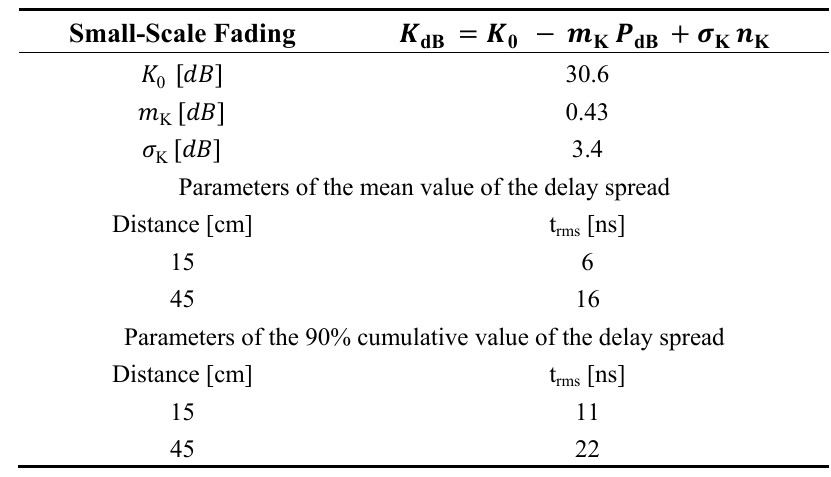
Table 6. Small-scale fading using Ricean distribution